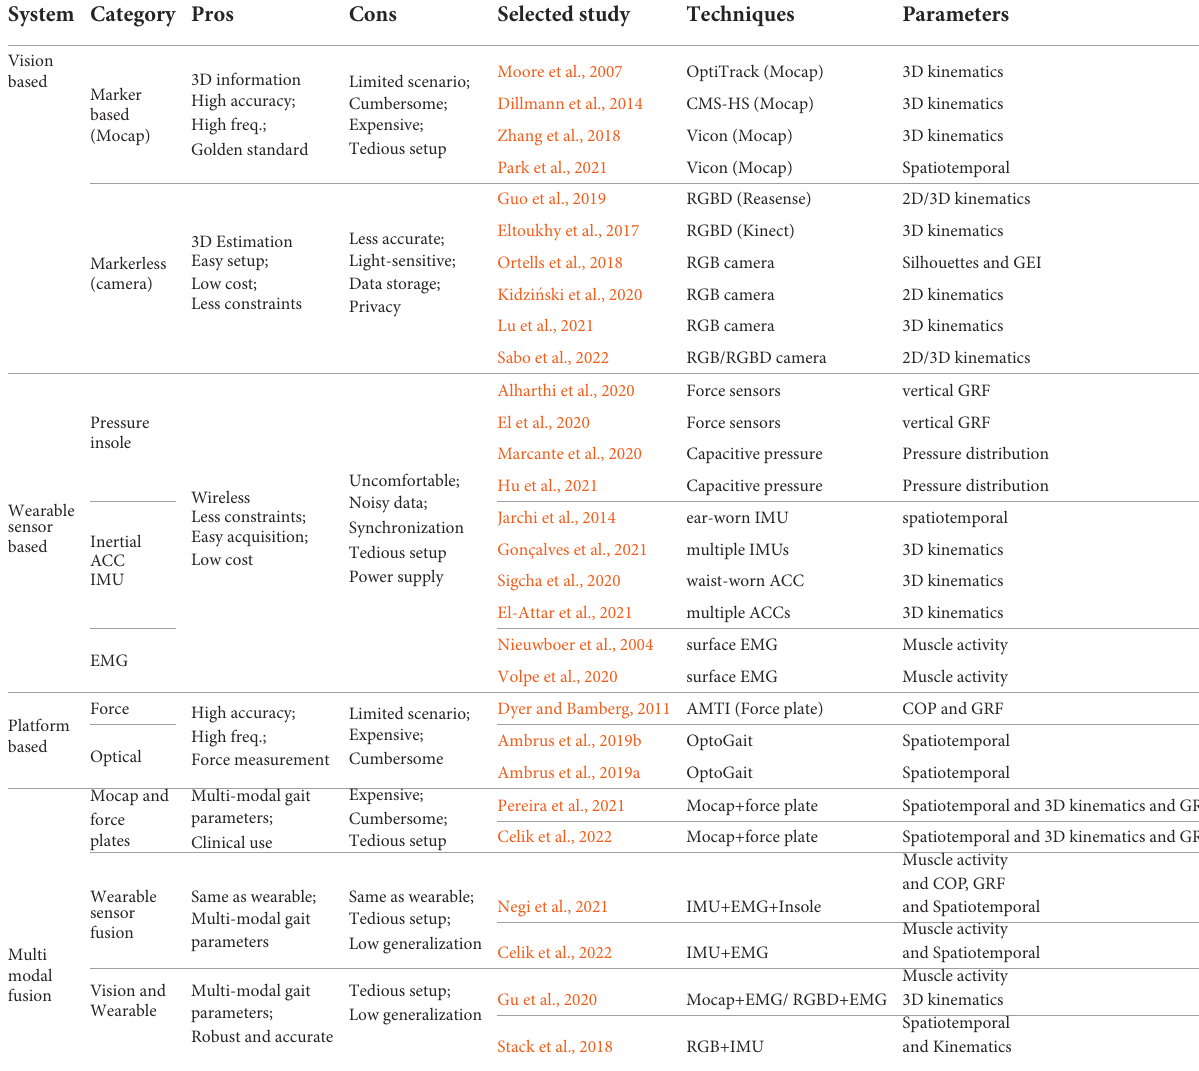
TABLE 3 Illustration of different gait analysis systems and their